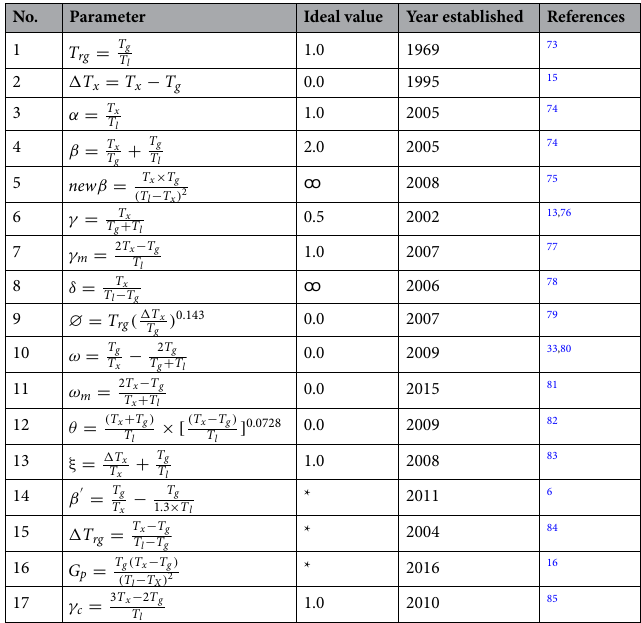
Table 1. Parameters (GFA criteria) expressed by characterization temperatures used as input features in this article (* means the ideal value has not been measured for this